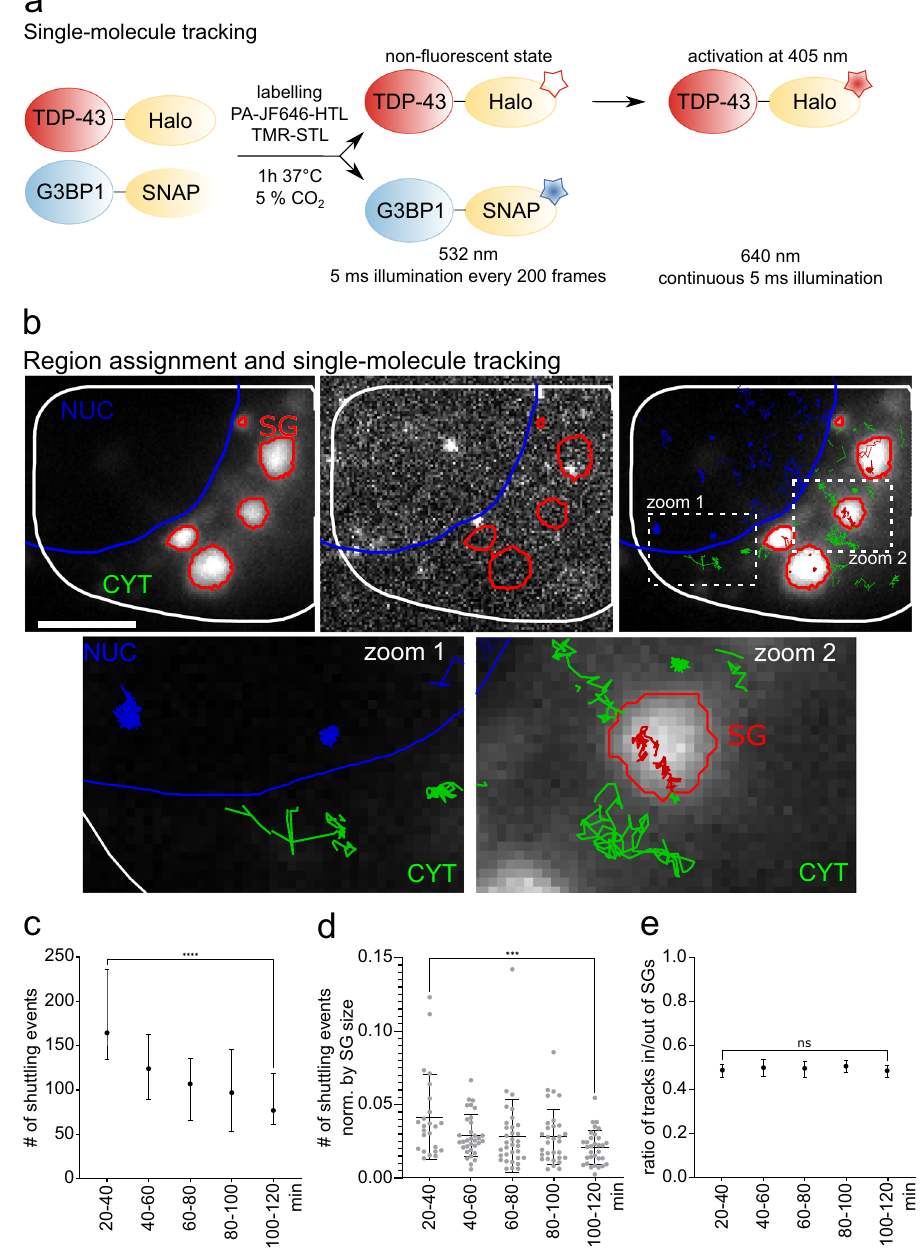
Fig. 2 | Overview of the single molecule tracking experiments and diffusion analysis.a Labeling and illumination scheme. TDP-43 Halo and G3BP1 SNAP are labeled withPA-JF646-HaloTagligand(HTL)andTMR-SNAP-Tagligand(STL)for1hat37°C and 5% CO 2 24h before imaging. TDP-43 Halo is illuminated continuously with 640nm and the PA-JF646-dye iscontinuously activated with 405nm, the TMR-dye is illuminatedwith 532nm and imagedevery200 frames. b Overview of the region assignmentandregion-speci fi ctrackassignment(cytoplasm/trackingregion:white outline and green tracks; nucleus: blue outline and tracks; stress granules: red outline and tracks). Zoom-ins and exemplary tracks for all regions are shown and show both, mobile TDP-43 Halo as well as more immobile molecules. Scale bar 5 µ m.